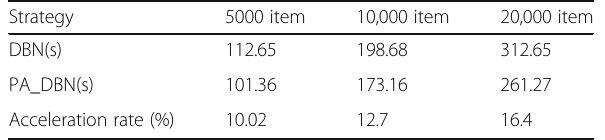
Table 3 The execution time of PA_DBN and